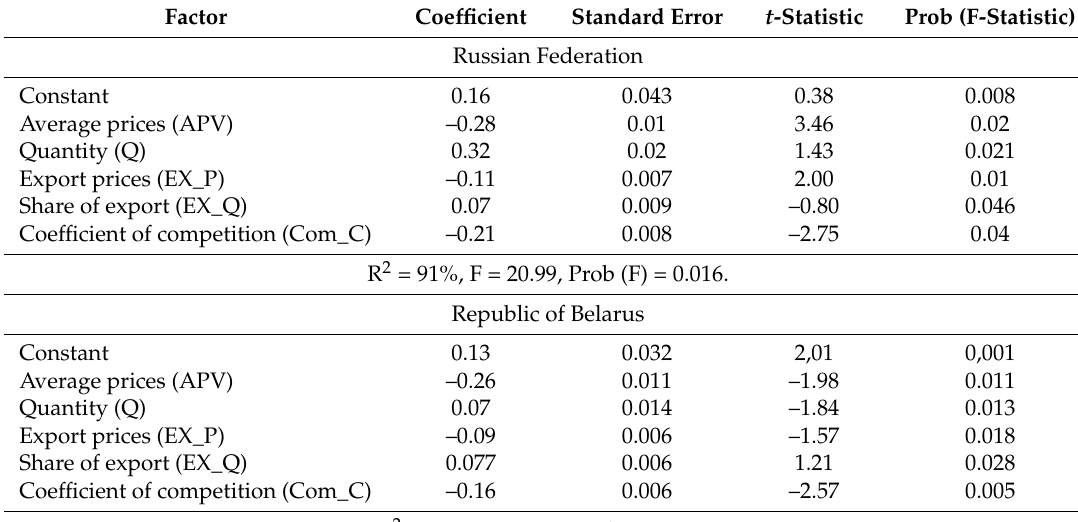
Table 5. Results of regression analysis of competition factors of barley in Russia, Kazakhstan, and Belarus from 2010 to